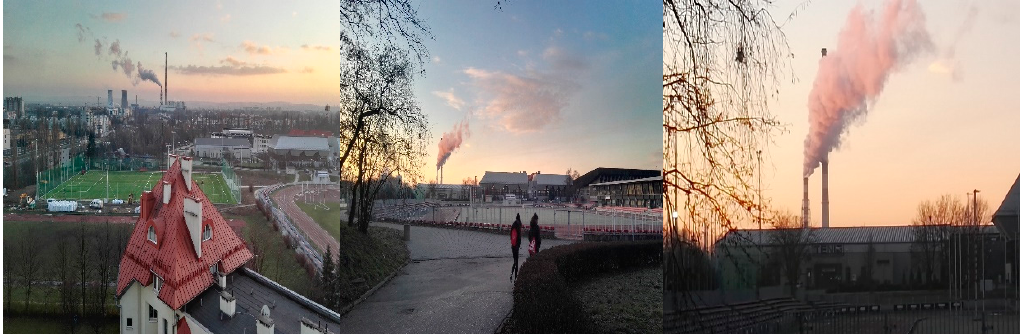
Figure 1. City smog in Kraków (source: authors’ archives).